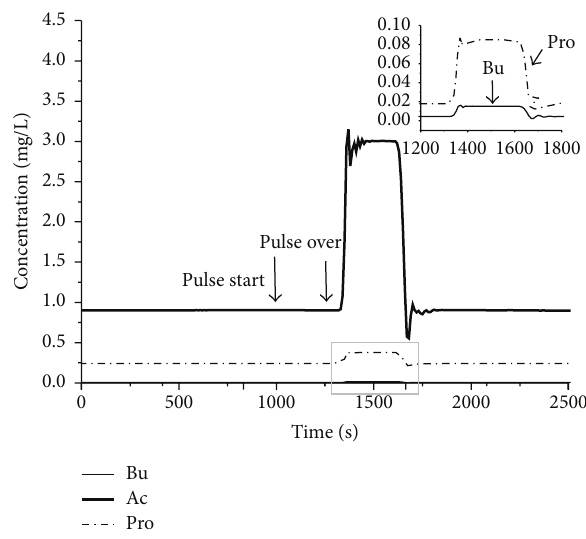
Figure 7: Effluent quality as a result of pulse COD